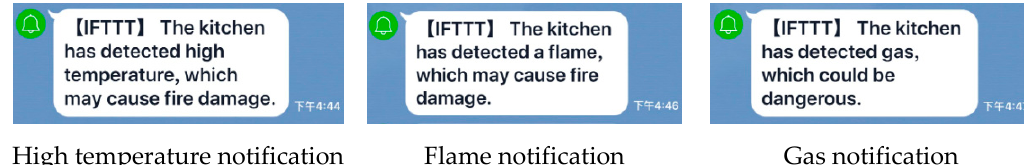
Figure 16. Gas shutoff device turned 90 degrees to turn off the gas supply.